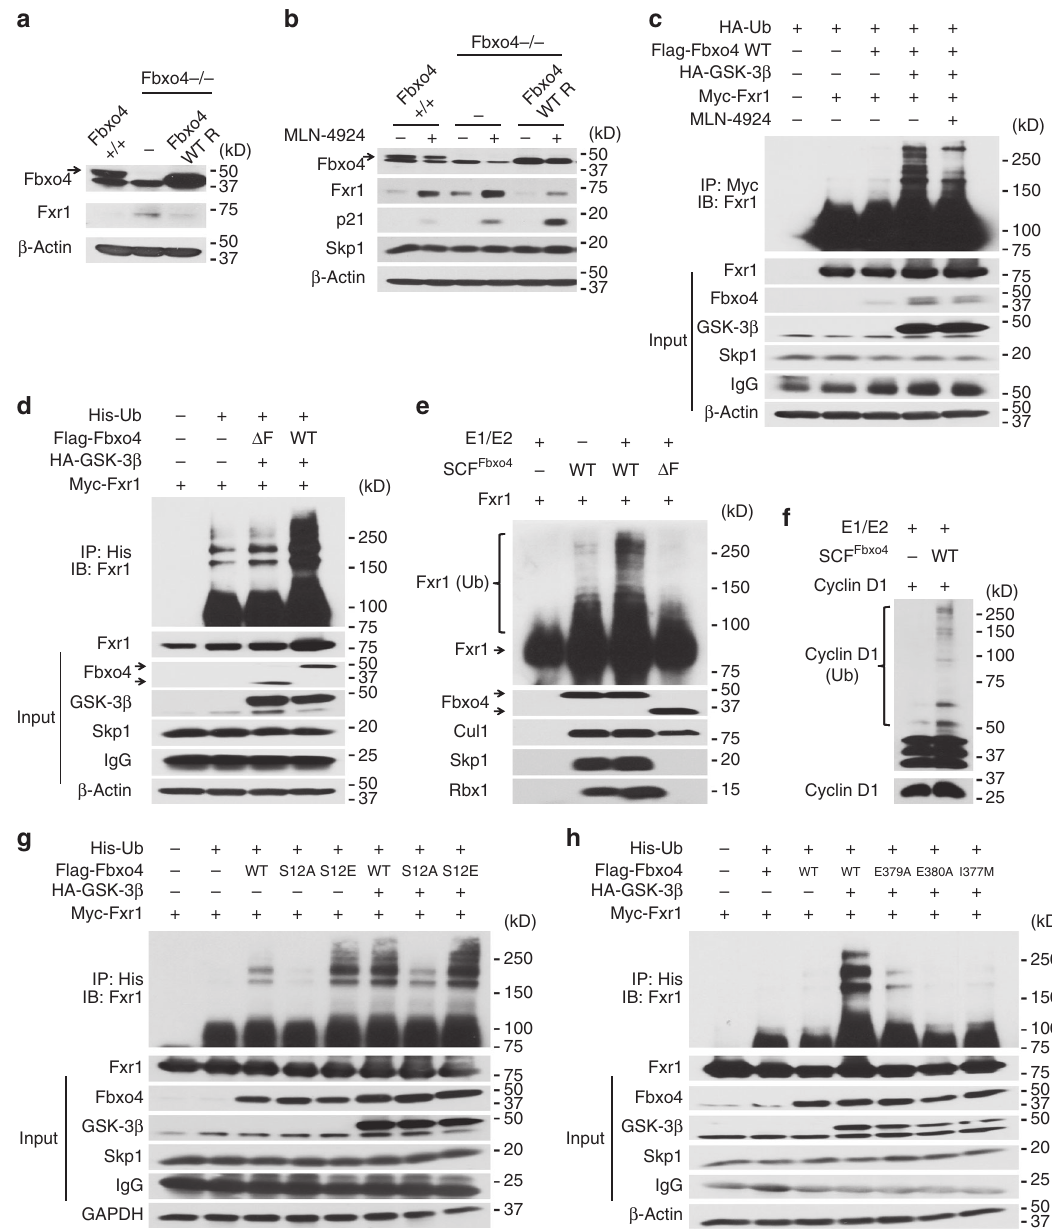
Fig. 2 Fbxo4 ubiquitylates Fxr1 both in vivo and in vitro. a Fbxo4 reconstitution reduces Fxr1 levels in Fbxo4 − / − MEFs. Note, arrow indicates Fbxo4; MEFs harbour a non-speci fi c band that migrates below bona fi de Fbxo4. b MLN-4924 rescues Fxr1 levels in both Fbxo4 + / + and − / − MEFs. c Fbxo4-induced Fxr1 ubiquitylation is enhanced by GSK3 β co-expression and suppressed by MLN-4924 treatment for 6 h. d WT but not Δ F Fbxo4 ubiquitylates Fxr1 in vivo. e In vitro assay illustrates Fxr1 is ubiquitylated by Fbxo4. f Cyclin D1 ubiquitylation is used as a control for in vitro assays. g WT and S12E Fbxo4 enhance ubiquitylation of Fxr1 in vivo. h E379A, E380A and I377M Fbxo4 mutants lose the ability to ubiquitylate Fxr1 in